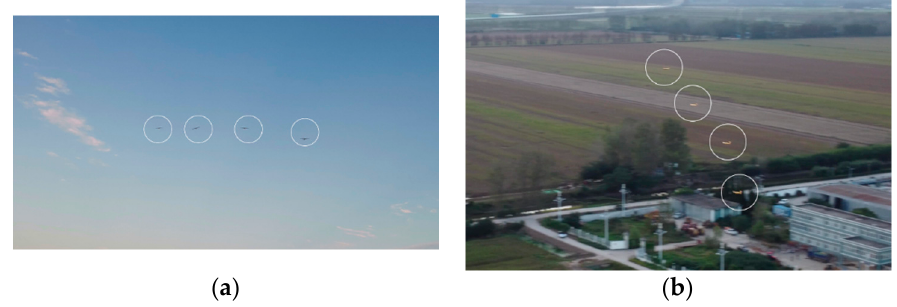
Figure 21. Actual flight diagram of the four-machine coordinated formation: ( a ) linear formation; ( b ) ladder formation.